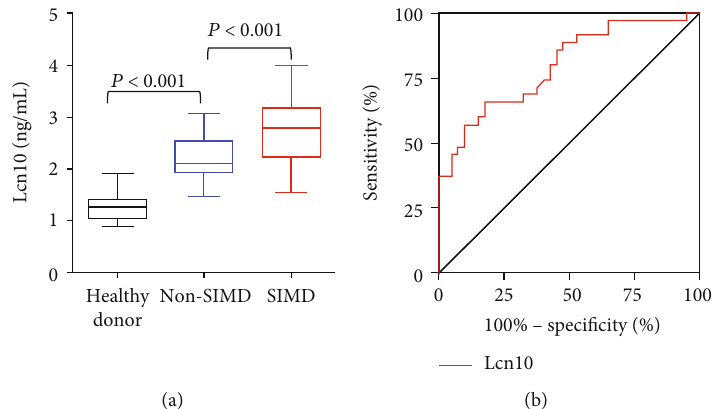
Figure 2: Diagnostic value of Lcn10 in sepsis-induced myocardial dysfunction. (a) Serum Lcn10 levels in the healthy donors, SIMD group, and non-SIMD group. (b) Receiver operator characteristic curves of Lcn10 for the diagnosis of SIMD. The AUC of Lcn10 for the diagnosis of SIMD in septic patients was 0.797 ( P < 0 : 001 ; 95% con fi dence interval, 0.696-0.897). Table 2: Sensitivity and speci fi city of Lcn10 levels for diagnosis of SIMD. Lcn10 cut-o ff (ng/mL)